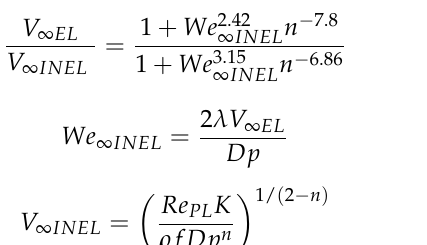
Figure 10. ( a ) Reynolds number and ( b ) drag coefficient estimations in the unconfined model. Figure 10b shows the drag coefficient values versus the different particle sizes at different HVFR concentrations. The drag coefficient improved as the HVFR concentration increased. At a spherical diameter particle size of 6 mm, the drag coefficient values were 0.94, 2.50, 13.12, and 451.19 using 1, 2, 4, and 8 gpt, respectively. Further investigation was conducted using velocity ratio ( V ∞ EL .) calculation to determine the HVFR elasticity impact on the settling rate. The velocity ratio of the spherical particle was measured using a variety of fluid concentrations and spherical particle sizes. The velocity ratio was determined by Equations (3)–(5) [35].